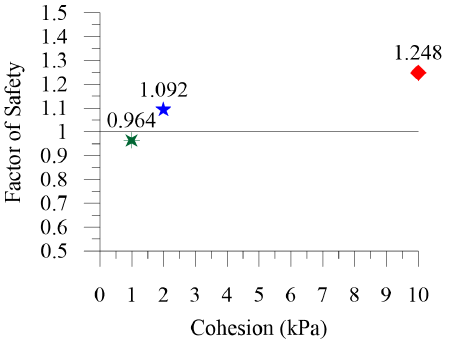
Figure 11. Factor of safety variation versus apparent soil cohesion.